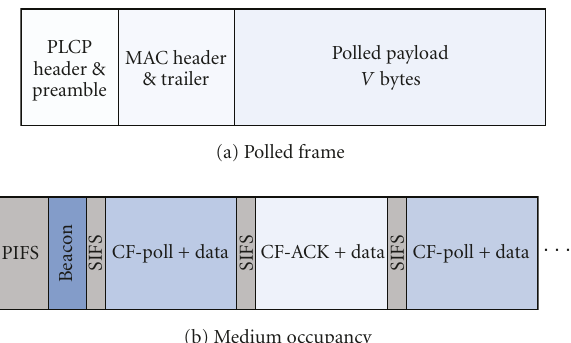
Figure 9: Polling frame model.